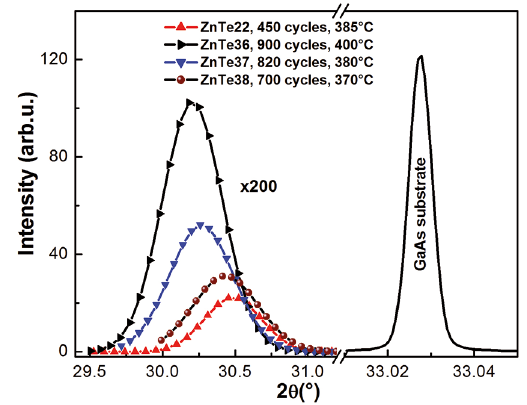
Figure 2: Thicknesses of the grown epitaxial layers as function of growth temperature.